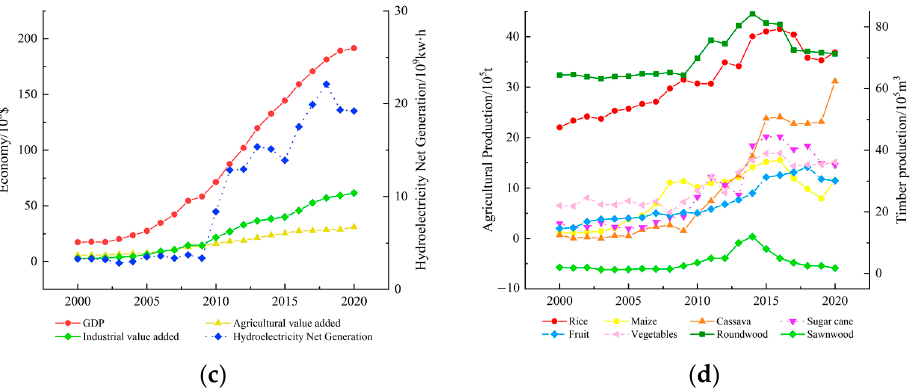
Figure 7. Development status of Laos from 2000 to 2020. ( a ) Climatic factors; ( b ) Population factors; ( c ) Economic factors; ( d ) Production factors.